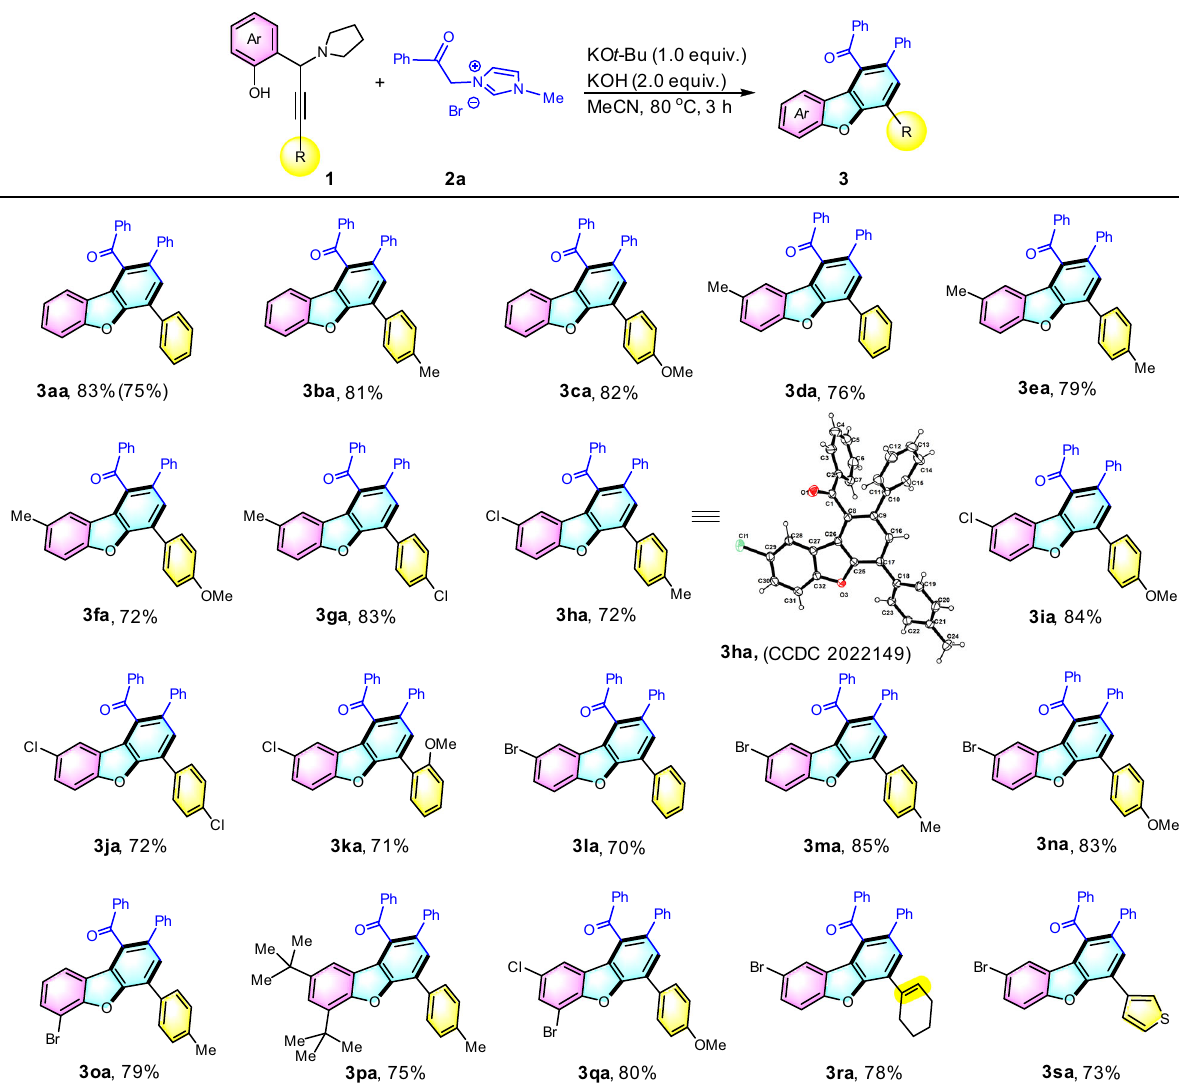
Fig. 2 Substrate scope of propargylamines. Reaction conditions: 1 (0.2 mmol), 2a (0.4 mmol), KO t -Bu (0.2 mmol), KOH (0.4 mmol) were stirred